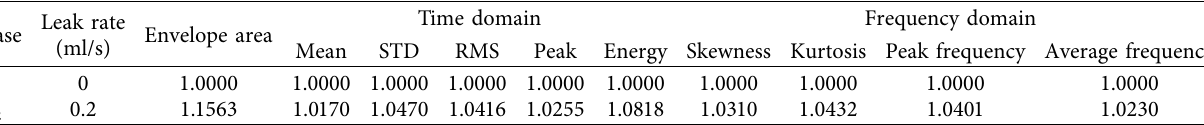
Figure 3: Characteristics in time and frequency domain of leak AE signals captured by PAC AE sensor R6a: (a) environmental noise; (b) 0.2ml/s. Table 1: Relative values of 10 characteristics